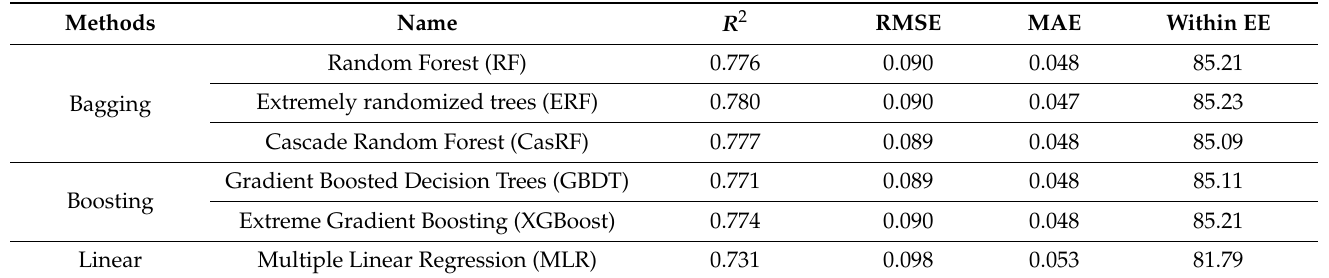
Table 3. Sample-based cross-validation results for the different machine learning